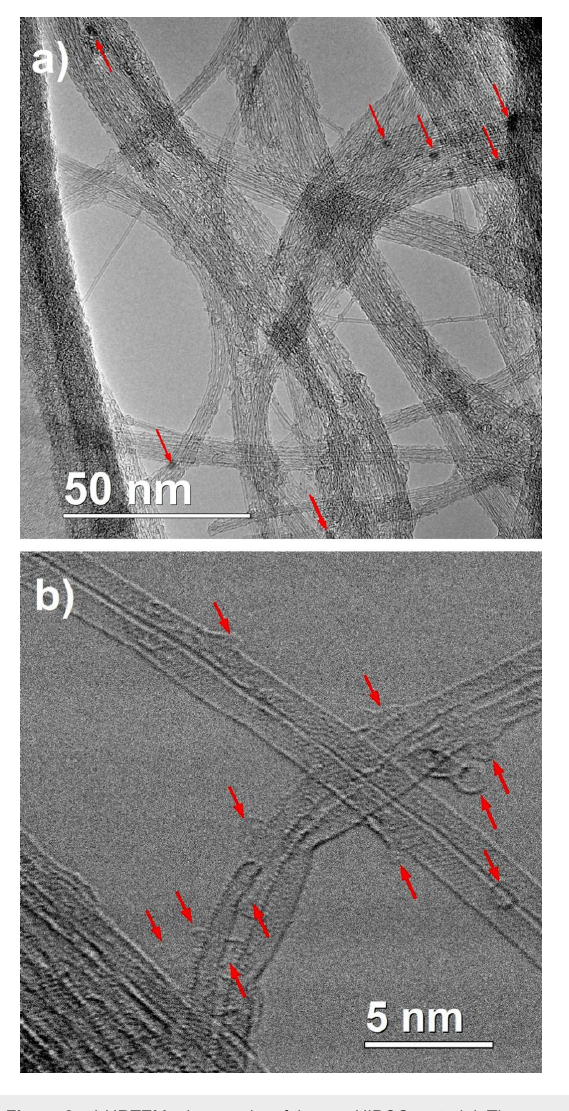
Figure 2: a) HRTEM micrographs of the raw HIPCO material. The arrows point out residual iron nanoparticles. b) HRSTEM BF image showing carbonaceous impurities at the surface of SWCNTs.